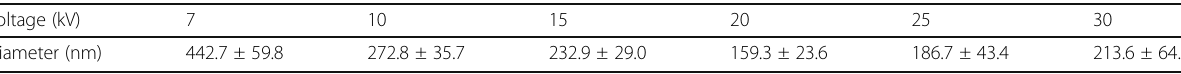
Table 2 The average diameter of PVA nanofiber under various voltage value Voltage